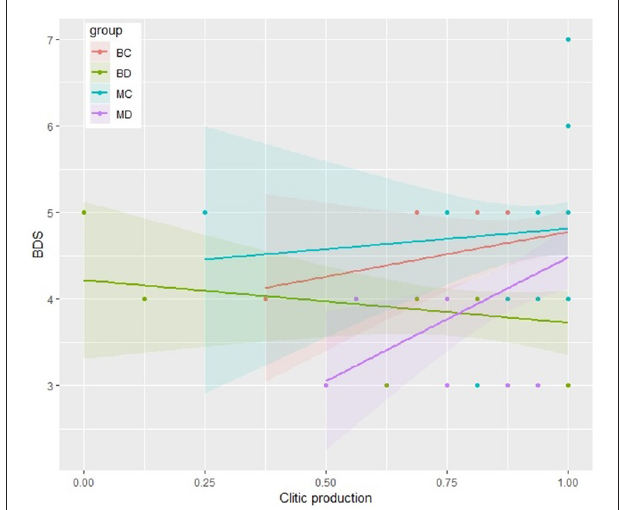
FIGURE 2 | Scatter plot representing the relationship between production of target clitics in the Simple Present and BDS for each group.